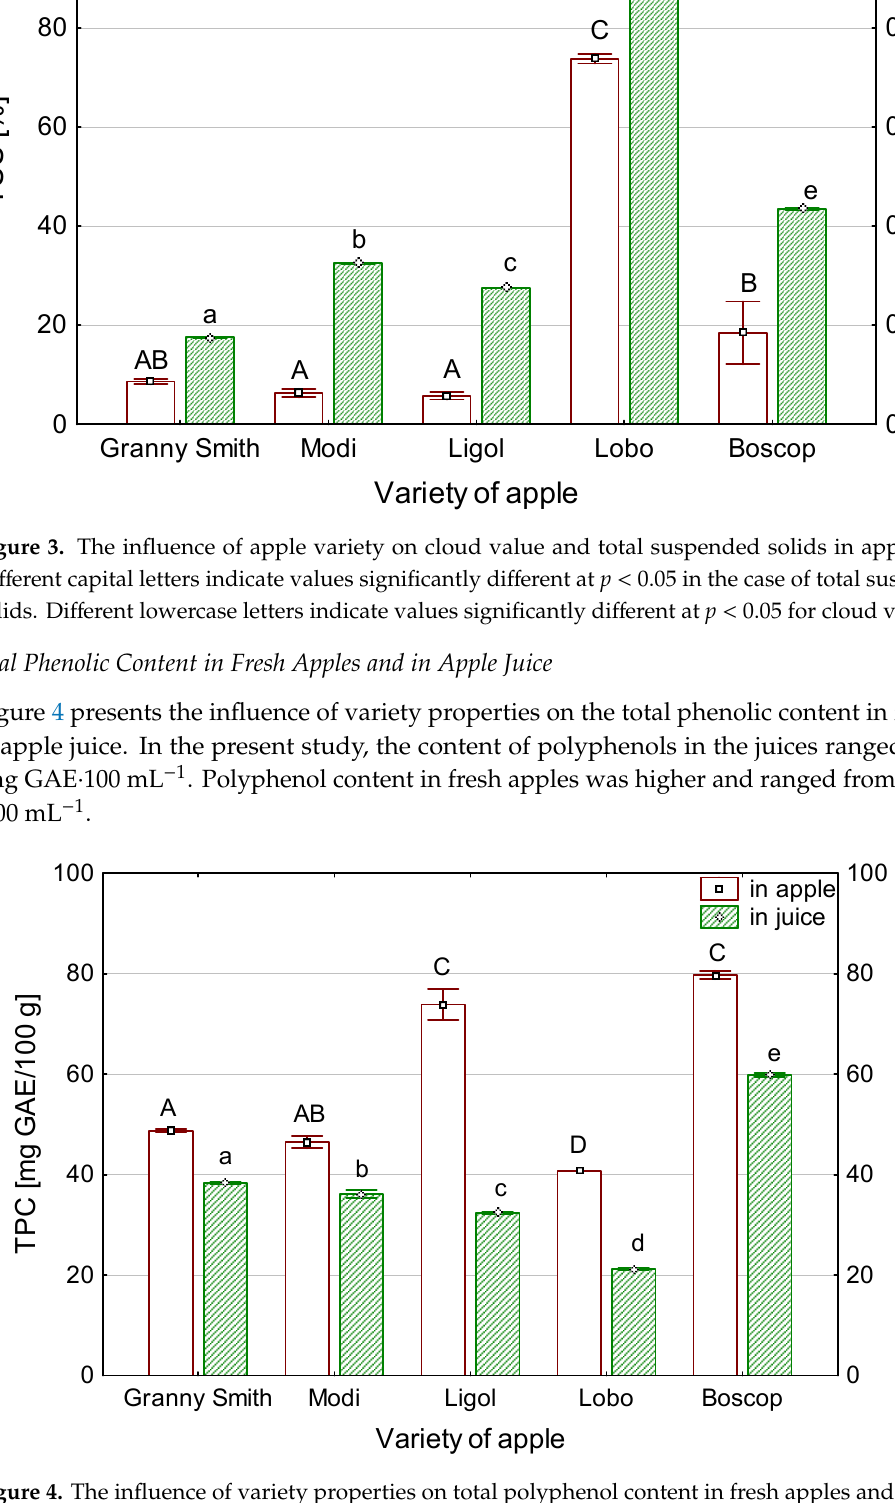
Figure 4. The influence of variety properties on total polyphenol content in fresh apples and in juice. Di ff erent capital letters indicate values significantly di ff erent at p < 0.05 in apples. Di ff erent lowercase letters indicate values significantly di ff erent at p < 0.05 in juices.